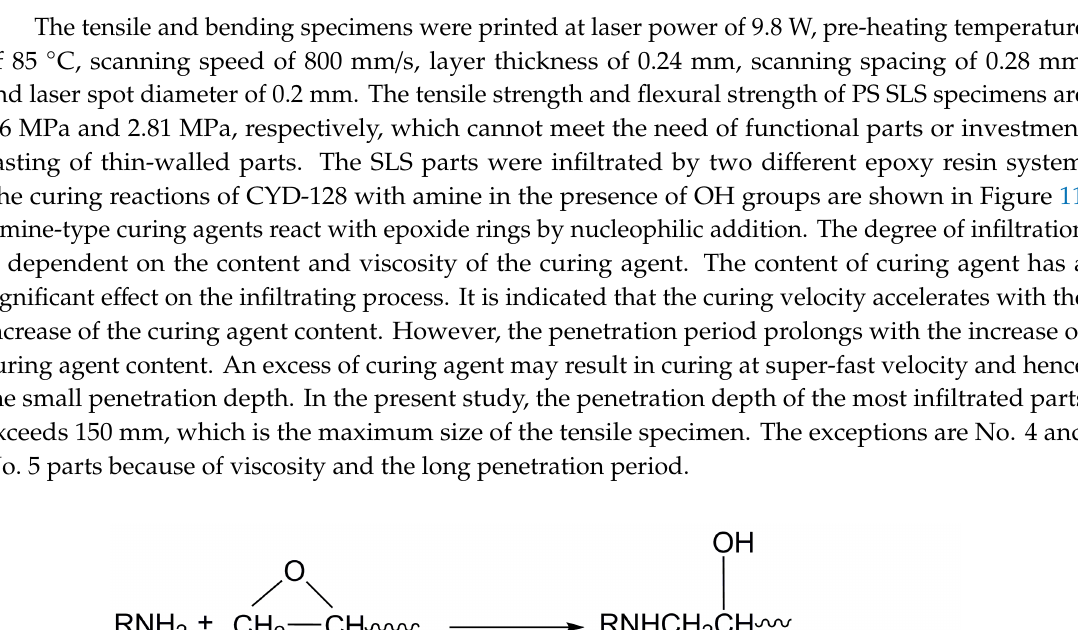
Figure 10. Temperature distribution in different part size (°C). ( a ) Large-size model; ( b ) small-size model.